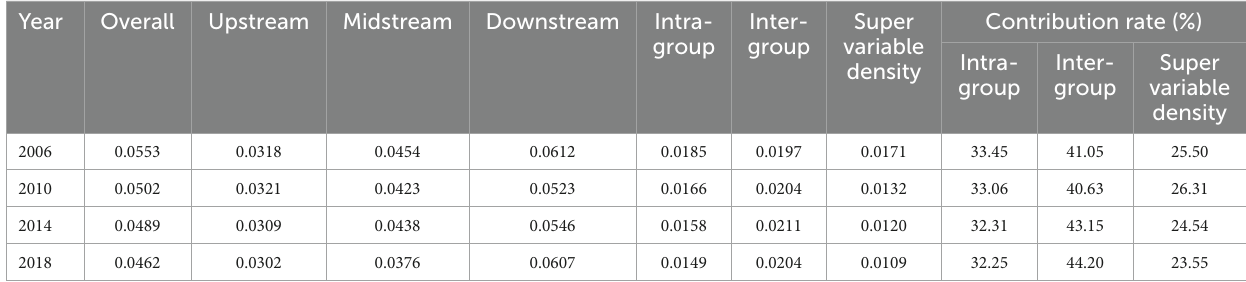
TABLE 2 Dagum Gini coefficient decomposition for ecological construction levels in the upper, middle, and lower reaches of the Yellow River